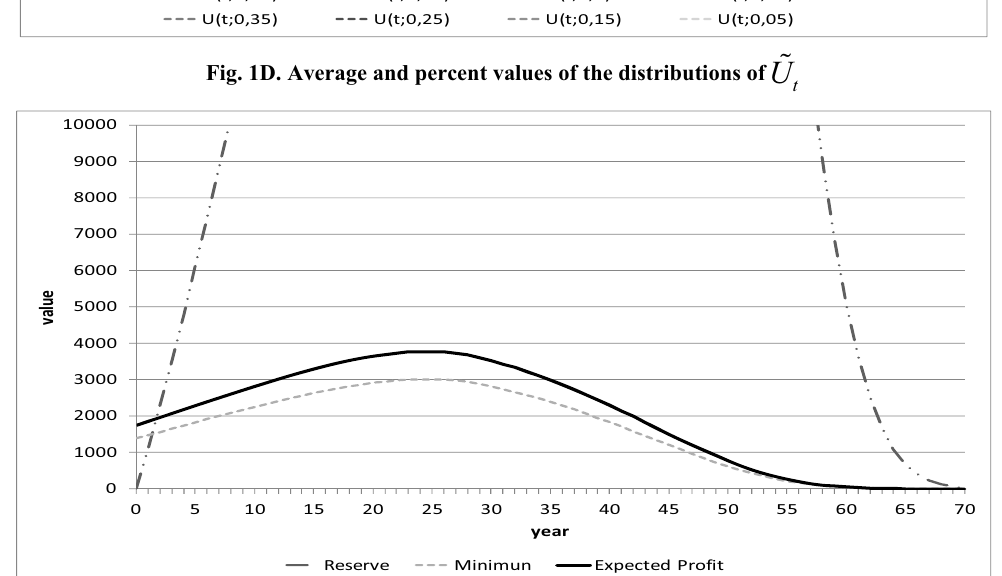
(cid:5) U and of the generation full t